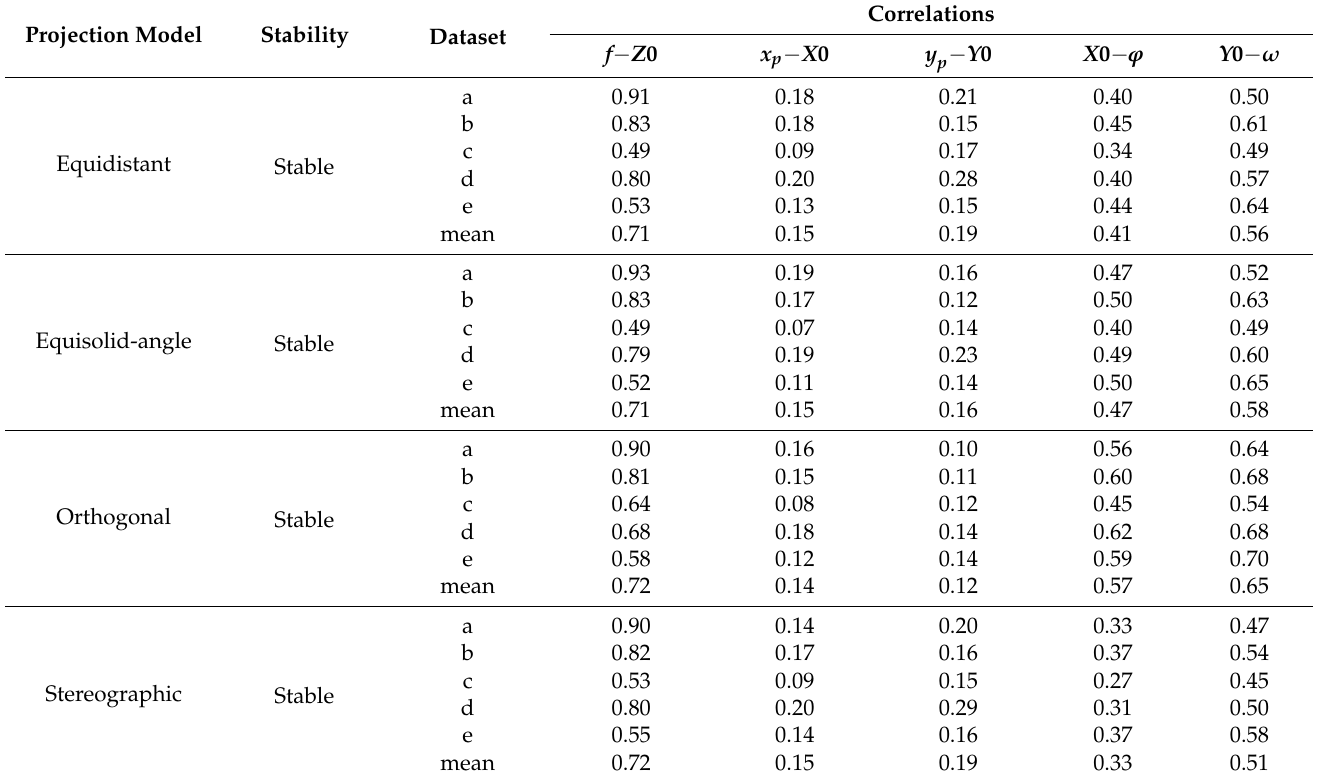
Table 5. Stability and correlations in simulated